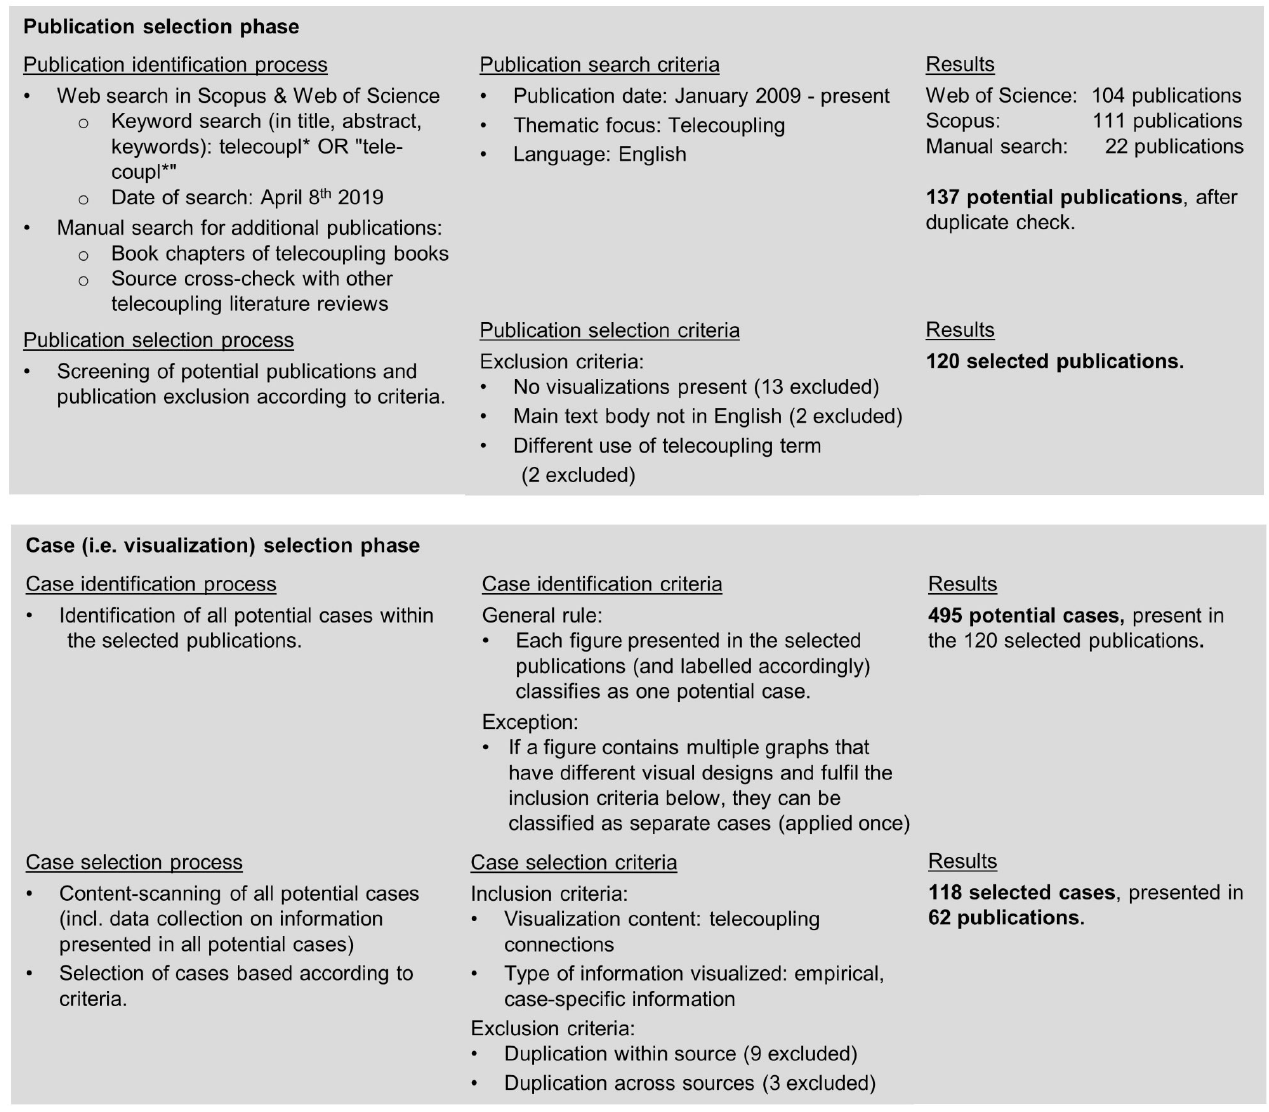
Fig. 3 . Publication and case selection